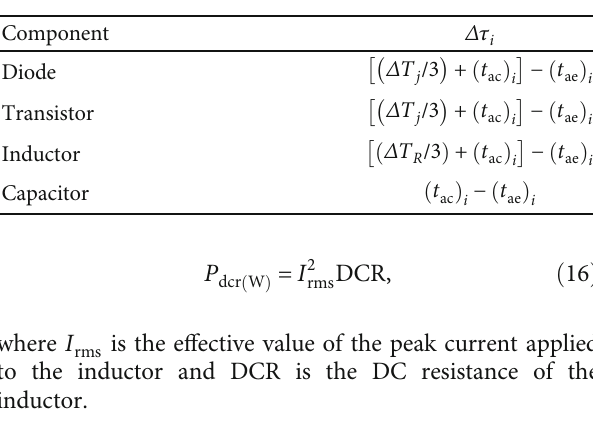
Table 6: Amplitude of thermal variation in on/o ff